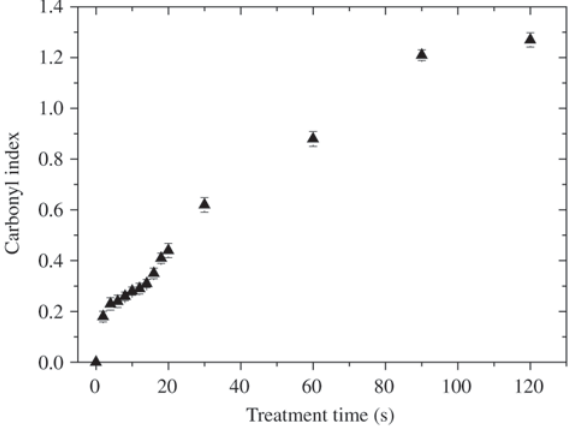
Figure 2. Carbonyl index as a function of corona treatment time of PP